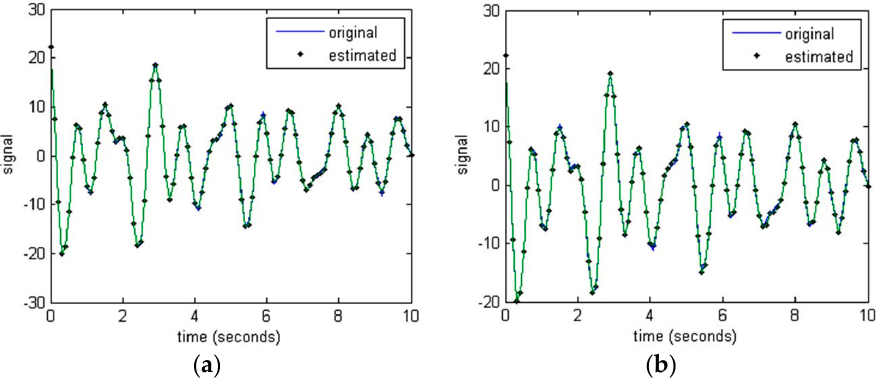
Figure 7. Comparison of the original and estimation signal (sampling 1/10 s, α = − 0.1). ( a ) ExPRO; and ( b ) MuPRO.